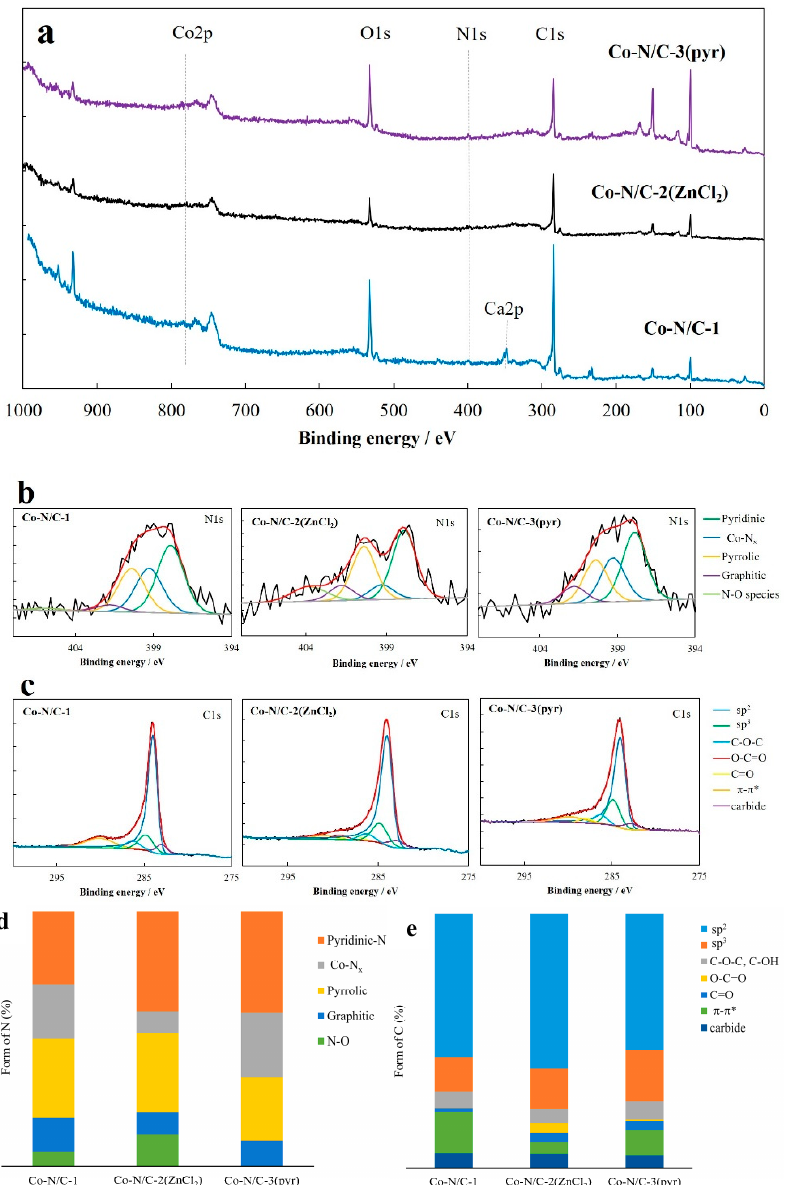
Figure 5. Wide-scan XPS spectra ( a ), detailed N1s ( b ), and C1s ( c ) spectra for selected Co-N/PDC catalysts (noted in Figure). Relative content of different nitrogen ( d ) and carbon ( e ) species obtained from detailed XPS spectra.